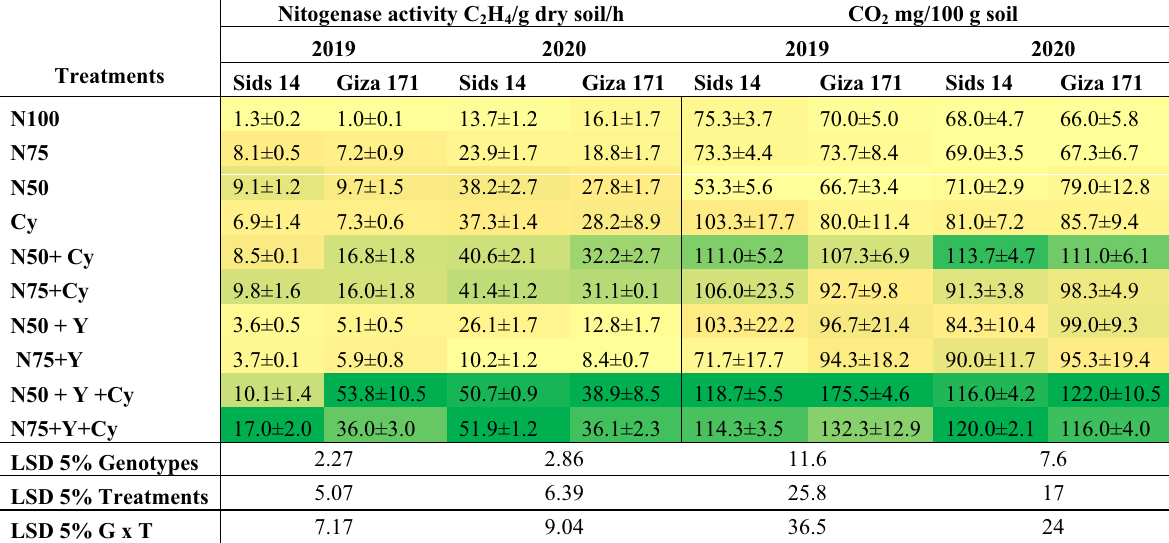
Table 1 Soil biological activity after 65 days from wheat growth as affected by cyanobacteria (Cy), yeast (Y) inoculation and nitrogen fertilization (N; nitrogen dose). The color scale pattern was generated in Excel, lower values are denoted in yellow color, whereas higher values are depicted by a green color. Each value is mean of 3 independent replicates SE ± Nitogenase activity C 2 H 4 /g dry